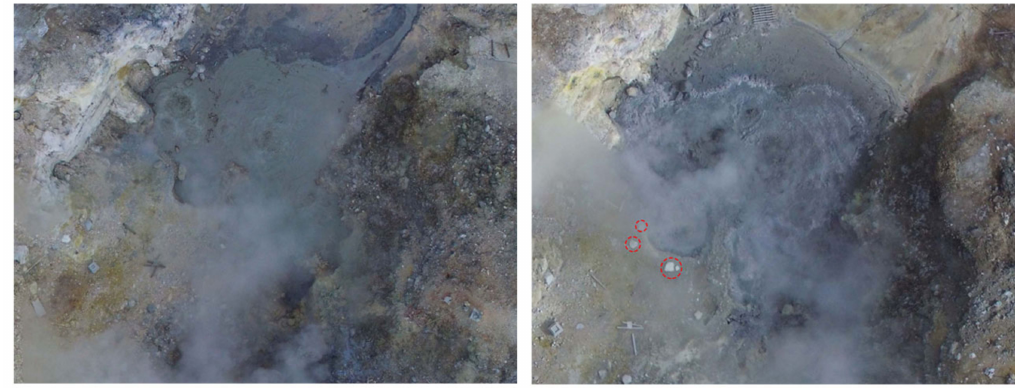
Figure 8. The difference between December 2019 ( left ) and May 2020 ( right ) shows the presence of rocks on the ground, very close to the main fumarole vent